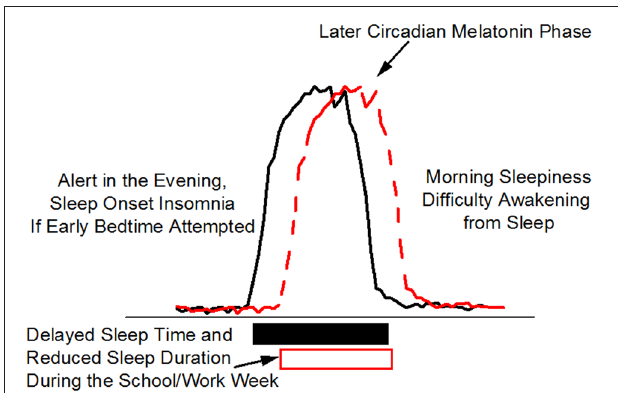
FIGURE 4 | Delayed Sleep Phase (DSP). Delayed sleep phase is the most common wakefulness-sleep challenge in adolescents and may lead to a DSP circadian sleep disorder. Individuals with DSP report difficulty falling asleep and difficulty awakening at the times required by school/work schedules. The phase delay in circadian timing, as indicated in this schematic by the later melatonin rhythm, may be related to biological (circadian physiology) and behavioral (e.g., social activities, increased light exposure in the evening, earlier school start times) changes that occur during adolescence. DSP combined with early school start times is thought to contribute to poor school performance and reduced sleep leading to chronic sleep loss during the week (open